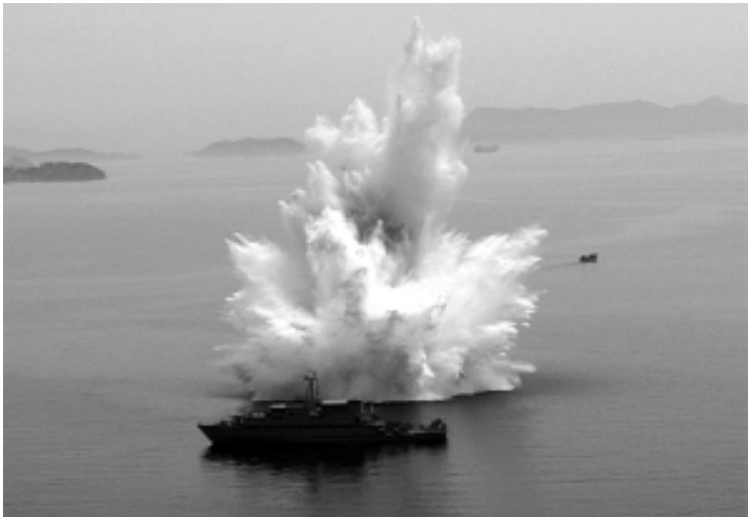
Fig. 6. View of MSH shock